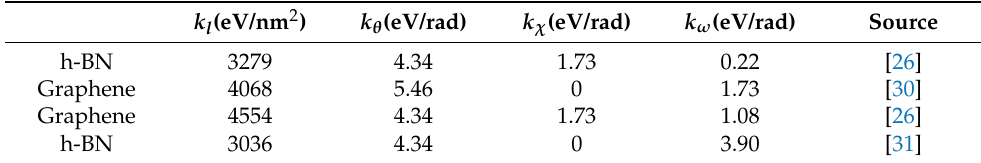
Table 1. The force field parameters of h-BN and